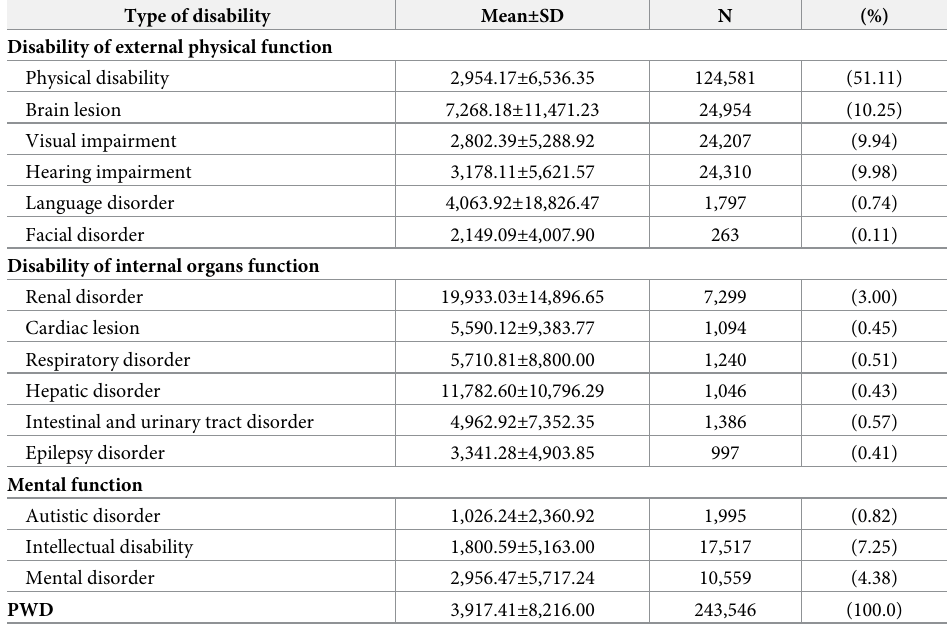
Table 3. Average medical care cost per person by types of disability